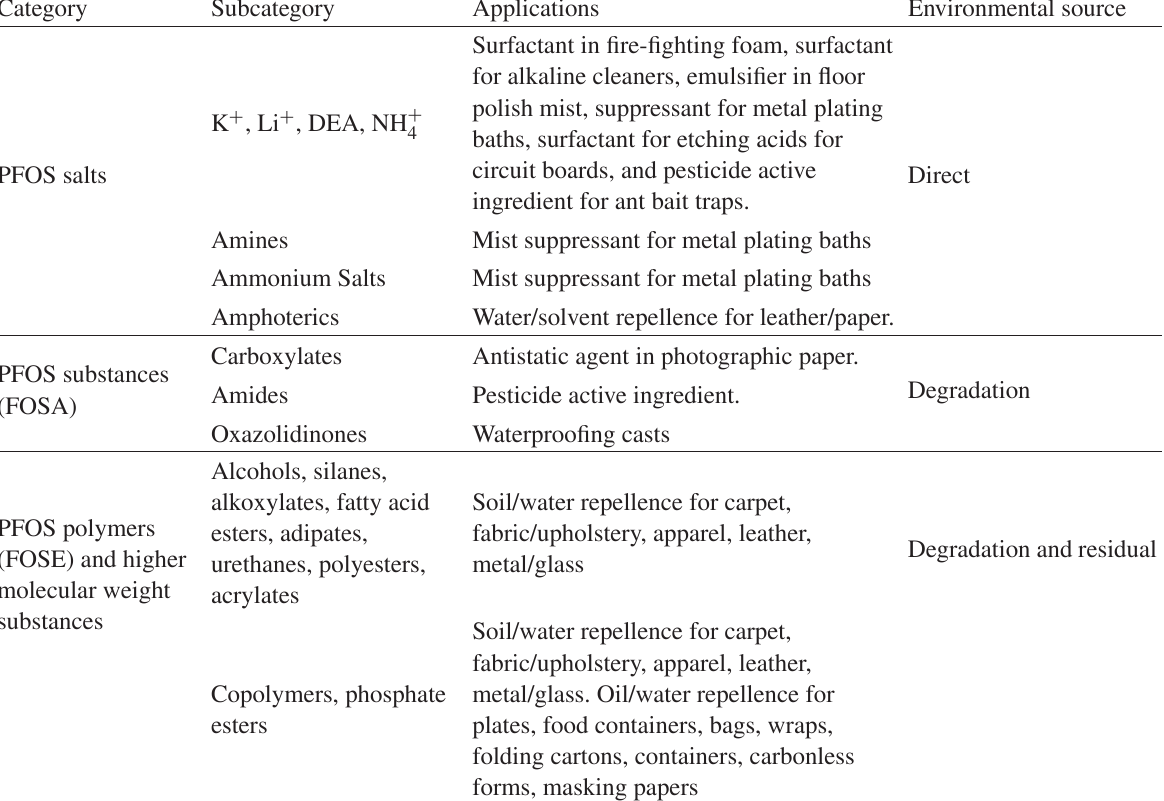
TABLE 2: Three major source pathways of PFOS-related compounds: direct, degradation and residual